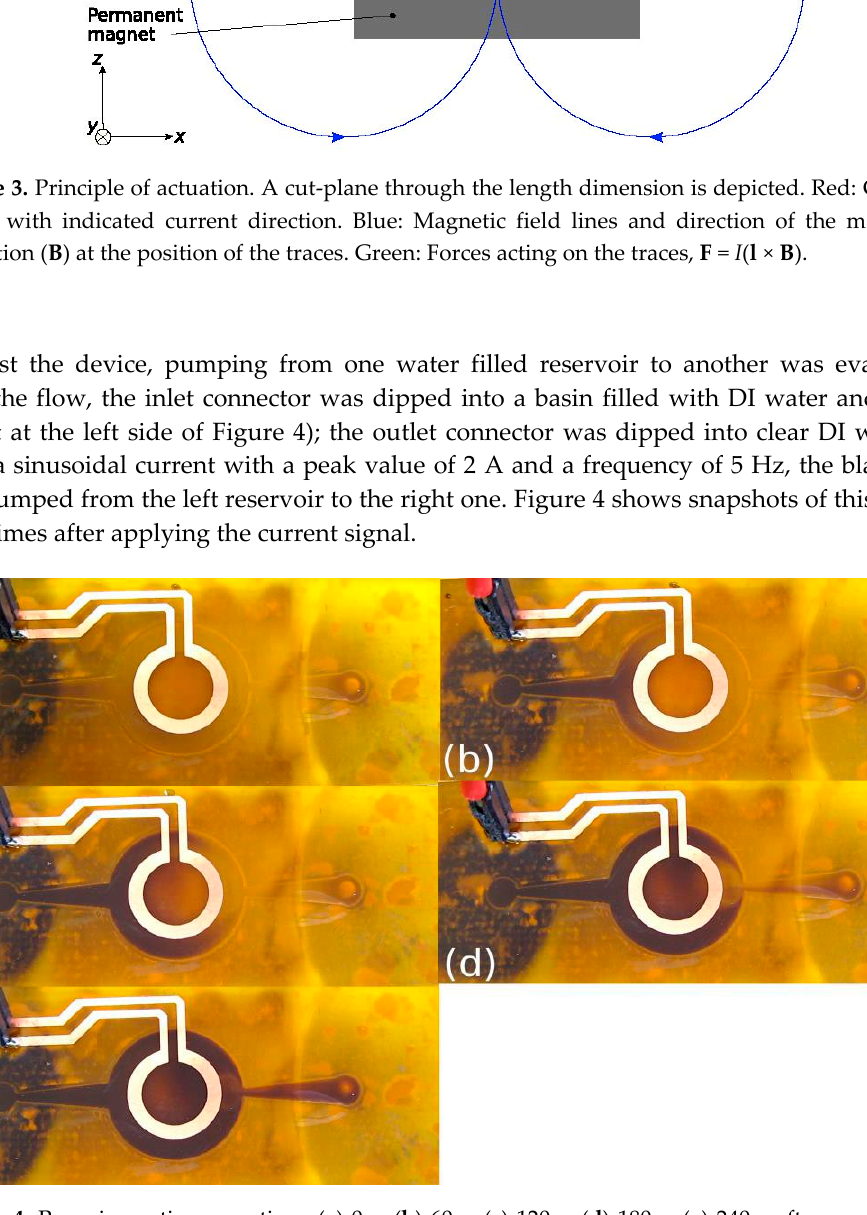
Figure 4. Pumping action over time. ( a ) 0 s, ( b ) 60 s, ( c ) 120 s, ( d ) 180 s, ( e ) 240 s after applying a sinusoidal actuation current (2 A/5 Hz) to the copper traces. The dark spot on the left represents the inlet reservoir (filled with black